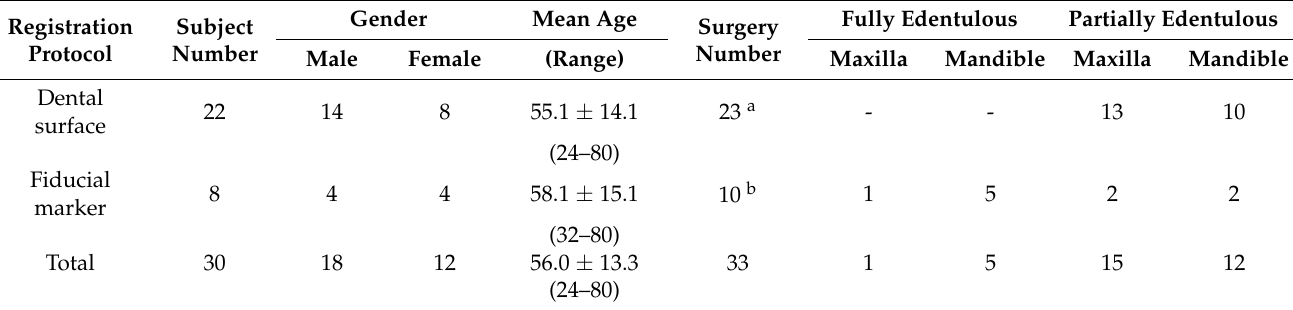
Table 1. Description of the patients and